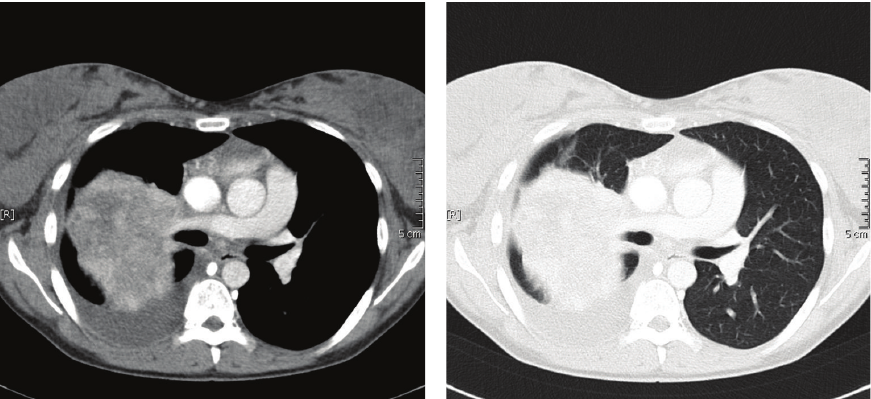
Figure 2: Contrast-enhanced computed tomography revealed pleural infiltration on the right side.